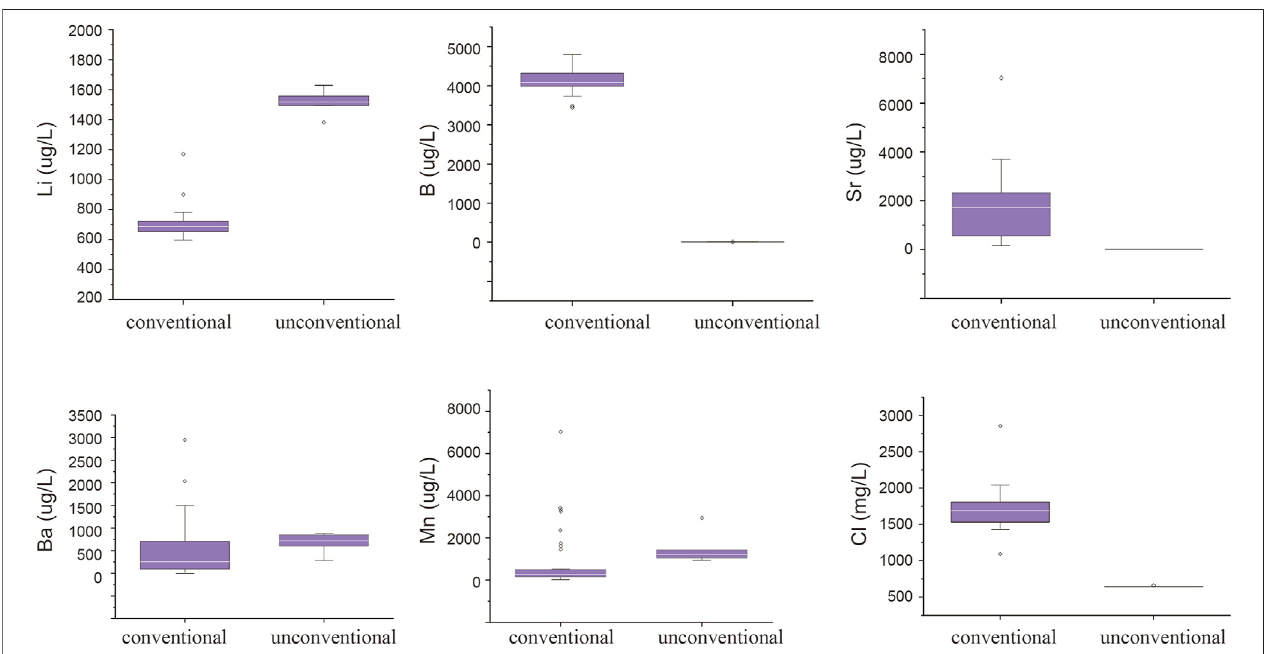
FIGURE 12 | Comparison between conventional and unconventional fl owback of Junggar